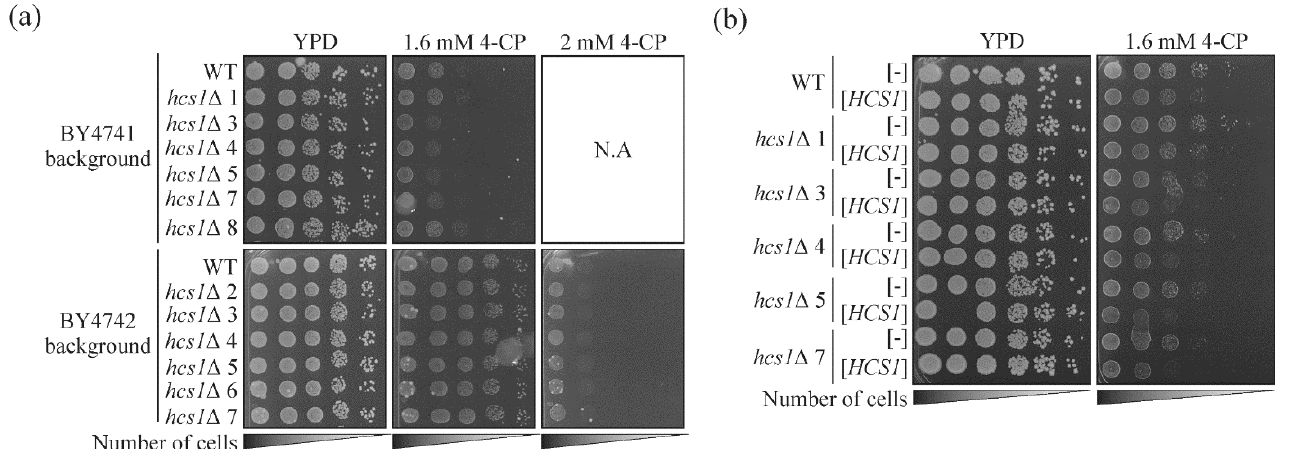
Figure 1. The influence of HCS1 gene deletion and its ectopic expression on sensitivity to 4- chlorophenol (4-CP). ( a ) The strain hcs1 ∆ is not hypersensitive to 4-CP on a solid rich medium. The serial dilutions of overnight cultures of wild-type (WT) or hcs1 ∆ strains (several clones, marked 1–8) in two backgrounds (BY4741 or BY4742) were spotted on the YPD medium supplemented with 4-CP as indicated. The plates were incubated for 5 days at 28 ◦ C. ( b ) The ectopic expression of HCS1 sensitizes cells to 4-CP. The wild-type (WT) or hcs1 ∆ strains in the BY4741 background carrying the empty ([-]) vector or plasmid with the HCS1 gene ([ HCS1 ]) were incubated overnight in SC-leu medium. The cultures were serially diluted and spotted on the YPD medium with or without 4-CP as indicated. The plates were incubated for 6 days at 28 ◦